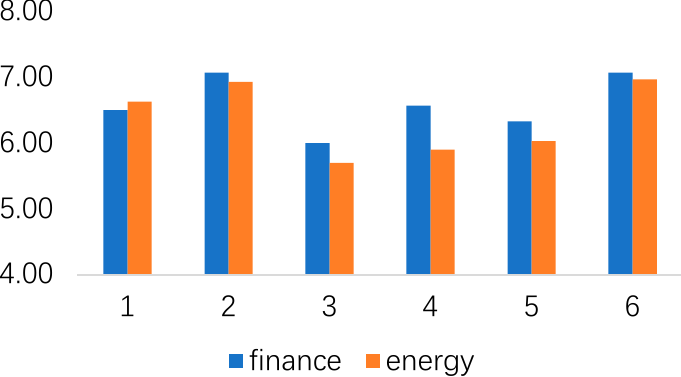
Figure 6. The relationship between perceived behavioral control under different stimuli.